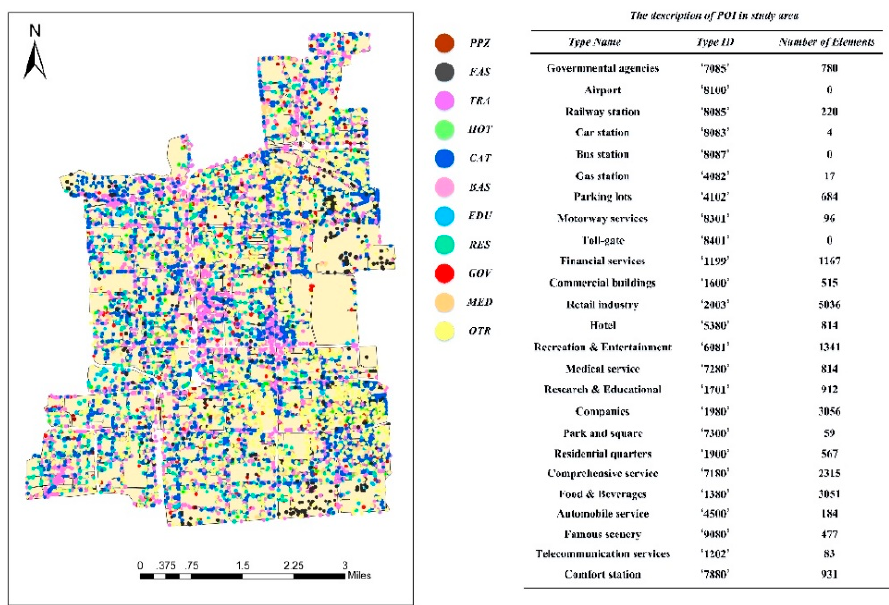
Figure 1. Illustration of study area (Xicheng District, Beijing) and the description of POI data. (Key to abbreviated names is in Table 1).